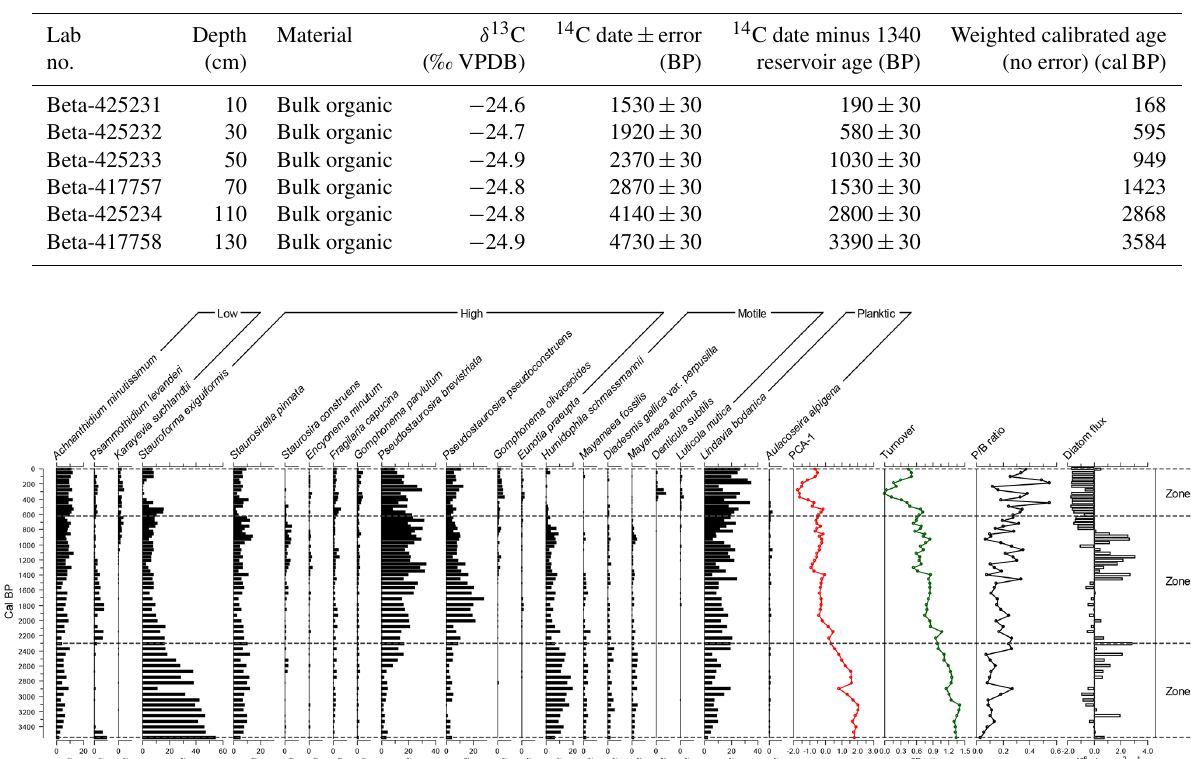
Figure 3. Diatoms shown greater than 3% in more than one sample. Diatom species are given as relative abundances. Also shown are PCA axis-1 scores for species and genera, compositional turnover values, planktonic-to-benthic (P / B) ratio data, and mean-centred diatom fluxes. Zones were delimited using CONISS – see text for